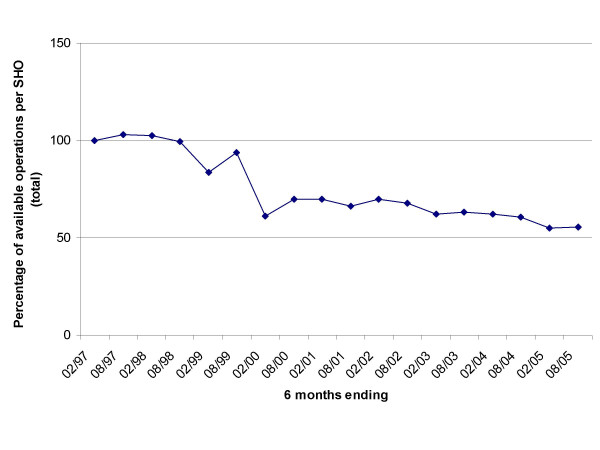
Changes in operations available per trainee across all specialties.